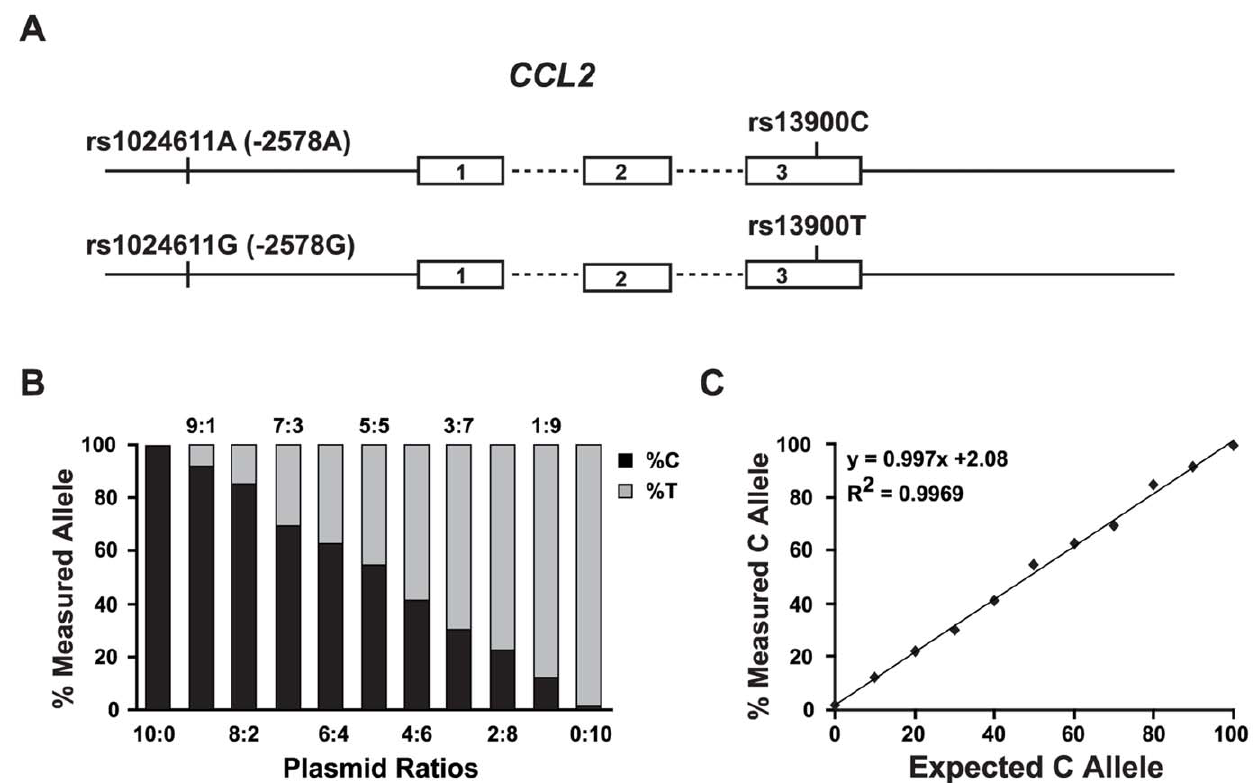
Figure 2. Validation of a pyrosequencing assay to measure AEI at rs13900 polymorphism. A. Schematic of the CCL2 gene structure and the LD between regulatory region polymorphism rs1024611 and the transcribed polymorphism rs13900. Numbered boxes are exons and the dashed lines connecting the exons are the introns. rs1024611 is located 2578 bp upstream of the CCL2 translational start site and rs13900 is located in the 3 9 UTR. B. Stacked bar graph represents the levels of the C (black) and T (grey) alleles in PCR products as determined by pyrosequencing. The PCRs were performed on the plasmid mixtures containing rs13900C and rs 13900T allele combined at the indicated ratios to simulate homozygous (10:0 and 0:10) and heterozygous samples (5:5) as well as different allelic levels (other indicated ratios). Data shown is from one representative experiment from three independent experiments which gave similar results. C. Regression analysis of amplification products obtained from the rs13900 C- and rs13900 T-bearing plasmids combined at different proportions. The measured levels of the C allele ( y-axis ) were plotted against the expected levels ( x- axis ). There was a near linear relationship between these values (R 2 =0.9969) suggesting that the pyrosequencing can serve as a sensitive assay to measure the levels of rs13900C and rs13900T alleles in heterozygous individuals. Similar results were obtained with using genomic DNA mixtures from homozygous and heterozygous individuals (data not shown).